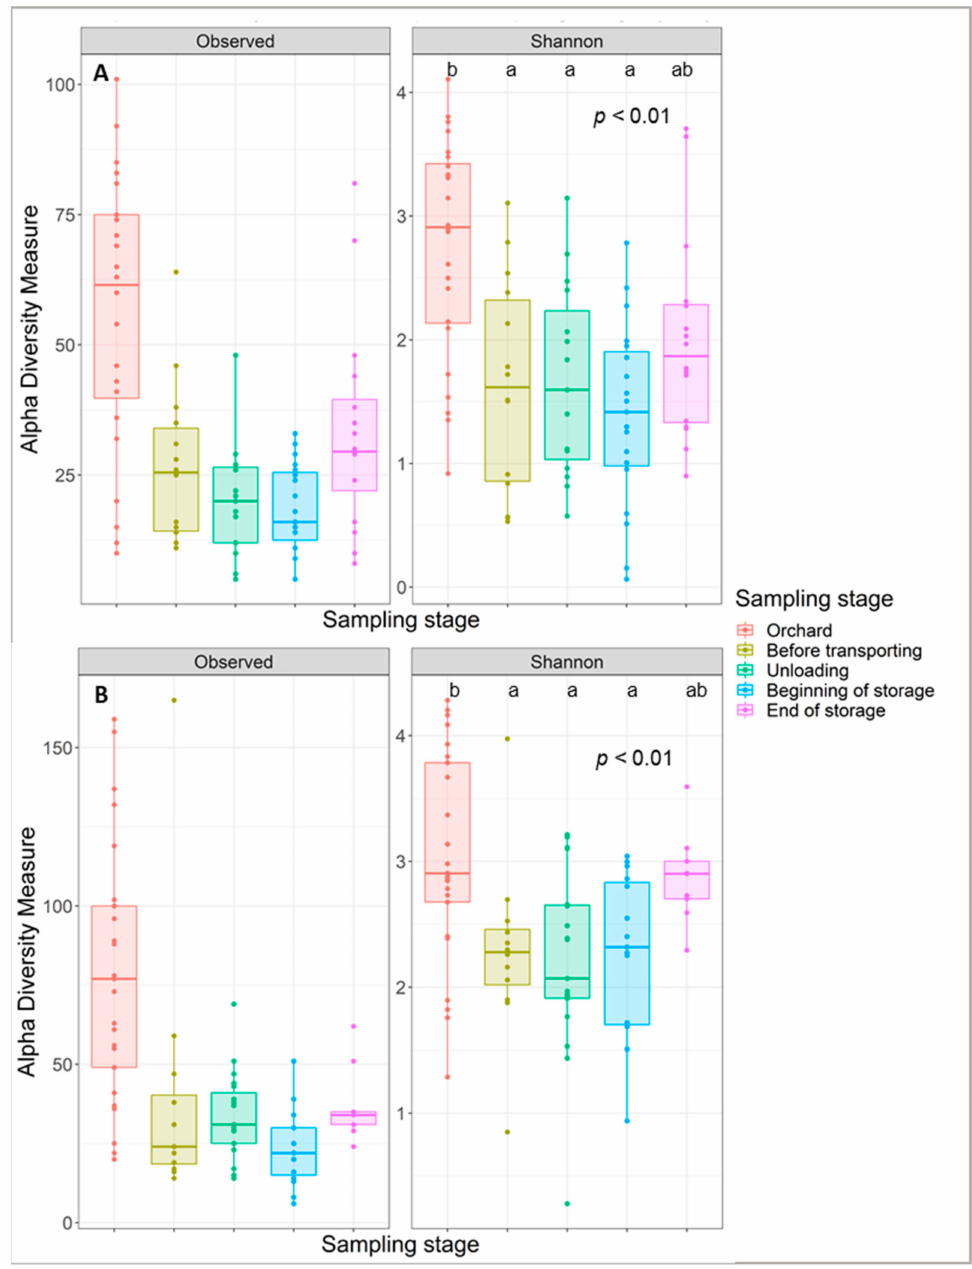
Figure 5. Boxplots illustrating the differences in the observed and Shannon diversity measures of the fungal ( A ) and bacterial ( B ) communities on the surface of the tested apples sampled at the different post-harvest